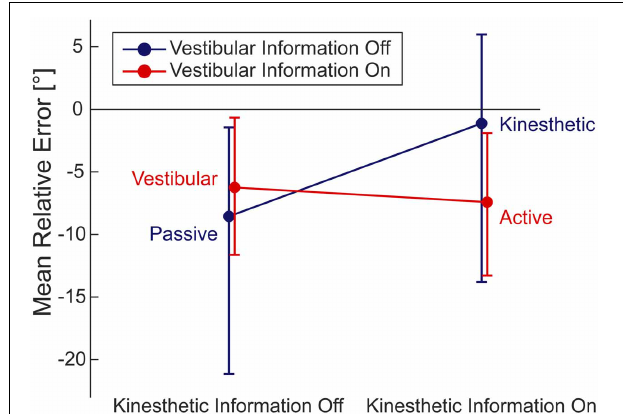
FIGURE 4 | Interaction of the mean relative errors in the respective four conditions. Within 2 × 2 ANOVA (95% CI). By inspecting the 95% CIs we find underestimation of the correct homing angle (i.e., negative relative error) in all conditions but the kinesthetic